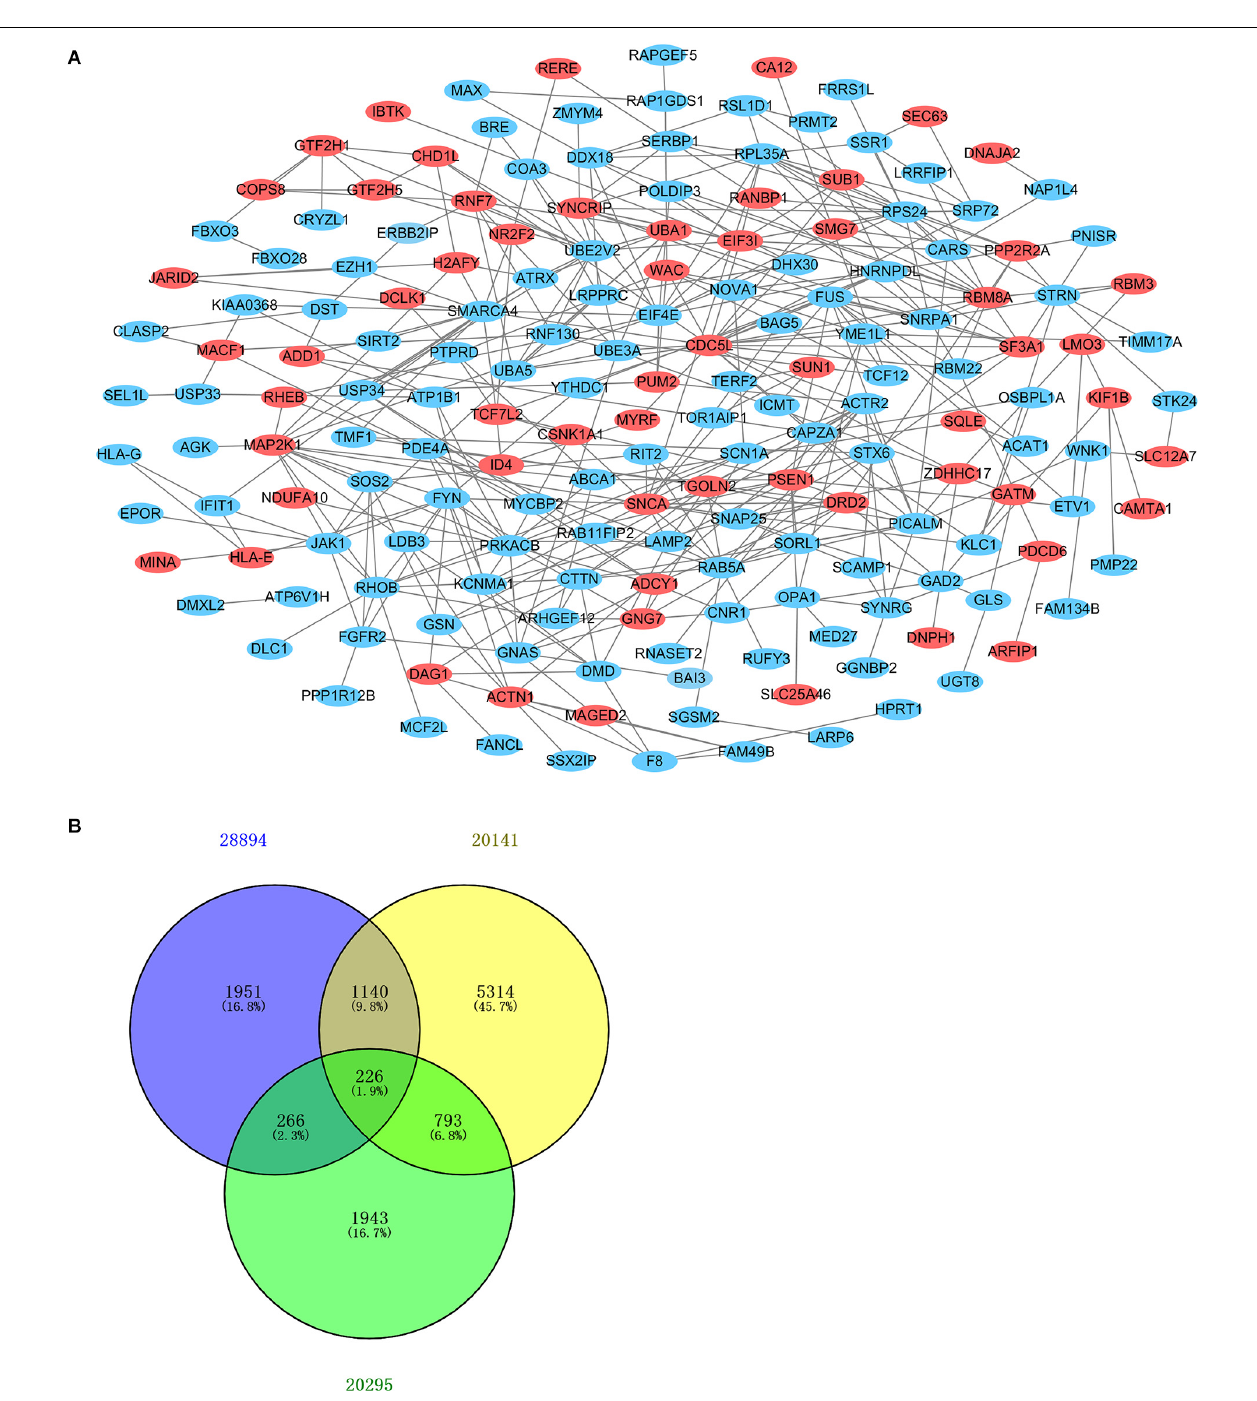
FIGURE 3 | Venn diagram and PPI network. (A) The PPI network of DEGs was constructed using Cytoscape. Upregulated genes are marked in light red; downregulated genes are marked in light blue. (B) DEGs were selected with the absolute value of fold change >1 and P -value < 0.01 among the mRNA expression profiling sets GSE28894, GSE20141, and GSE20295. The three datasets showed an overlap of 226